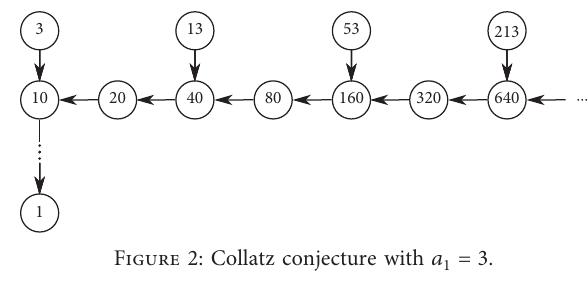
Figure 2: Collatz conjecture with a